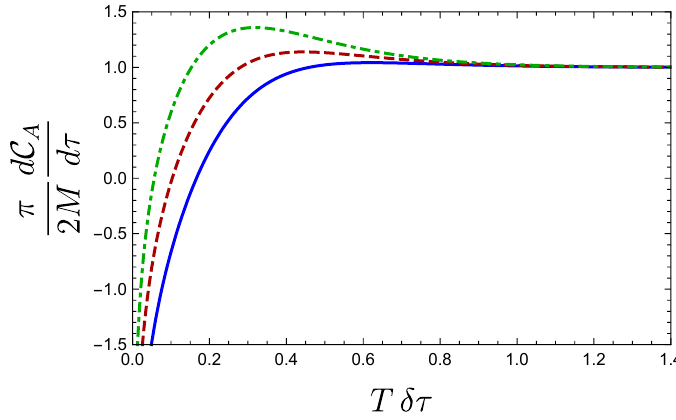
Figure 18 . Plot of [ (cid:25)= (2 M )] d C A =d(cid:28) for R= ~ L = 0 : 5 (solid blue), R= ~ L = 1 : 0 (dashed red) and R= ~ L = 2 : 0 (dot-dashed green). The curves diverge at (cid:28) = 0 and approach to 1 from above at late